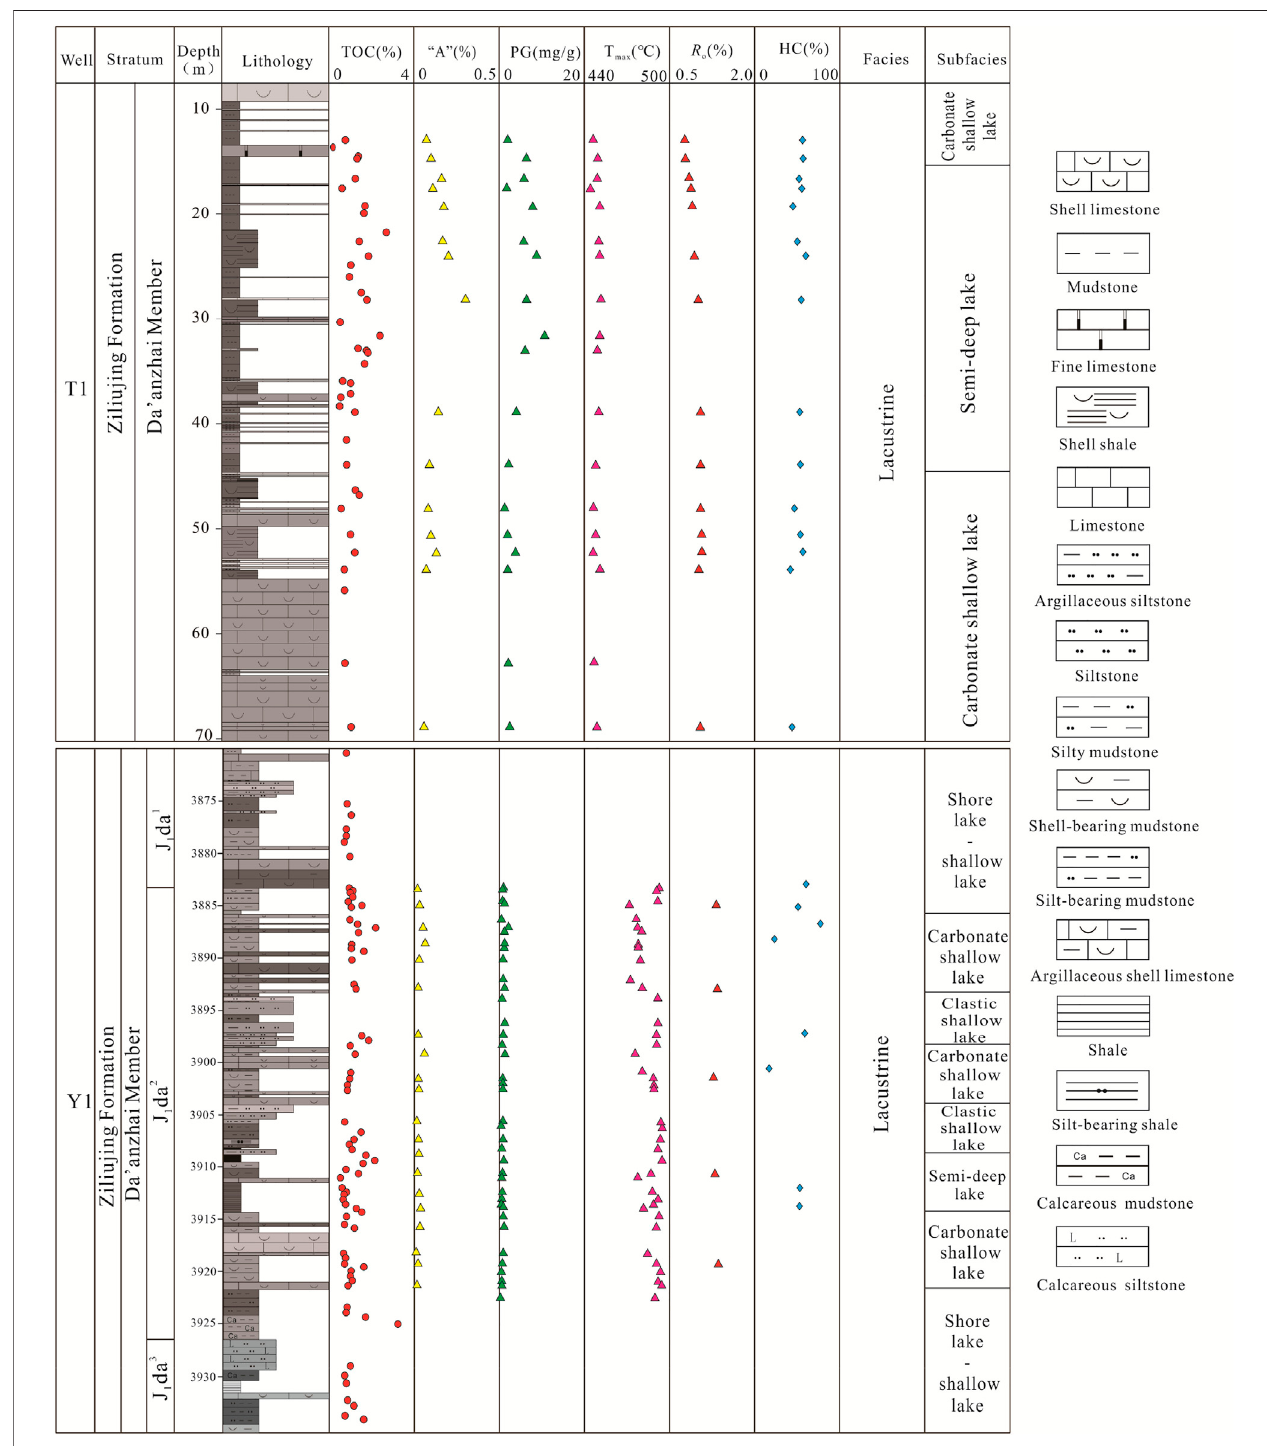
FIGURE 2 | Organic geochemistry histogram of J 1 da of wells Y1 and T1.